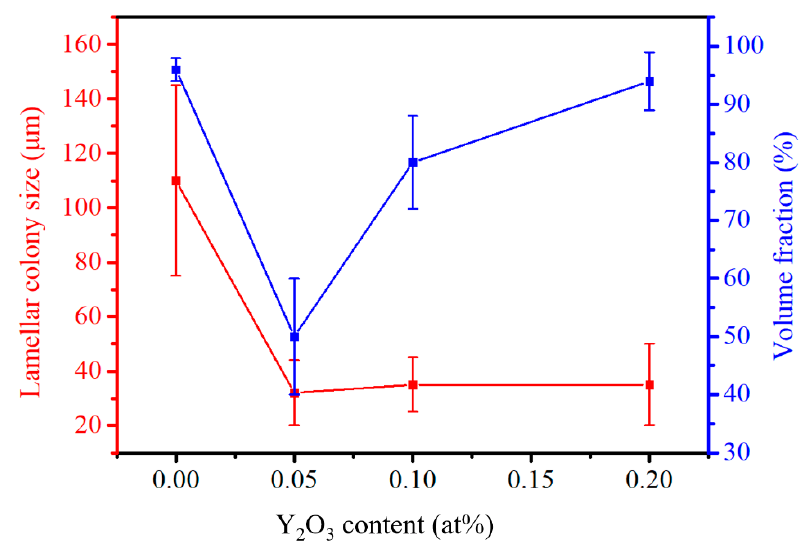
Figure 4. Lamellar colony size and its volume fraction with different content of Y 2 O 3 addition.